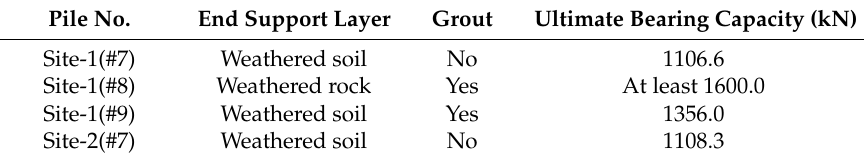
Table 4. Ultimate bearing capacity according to the static load test results.